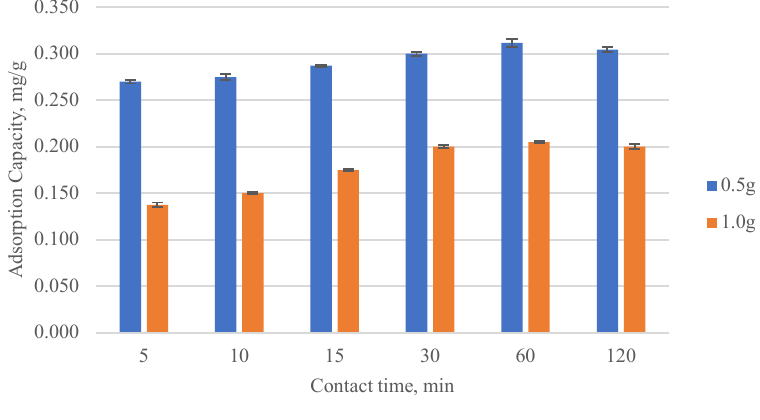
0.300 mg/g. With an adsorbent mass of 1.0 g, the uptake of copper ions was 0.200 mg/g within 30 min.